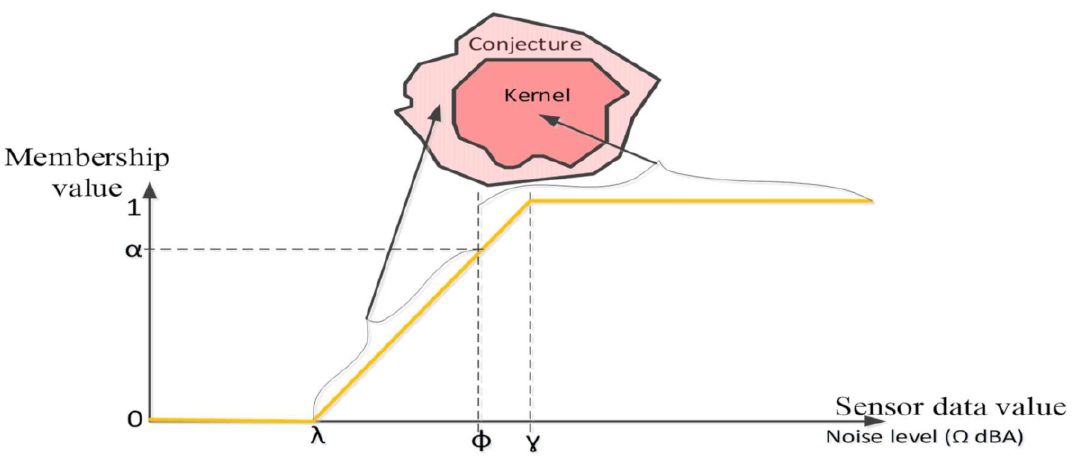
Figure 8. Illustration of a S-shape membership function for noise